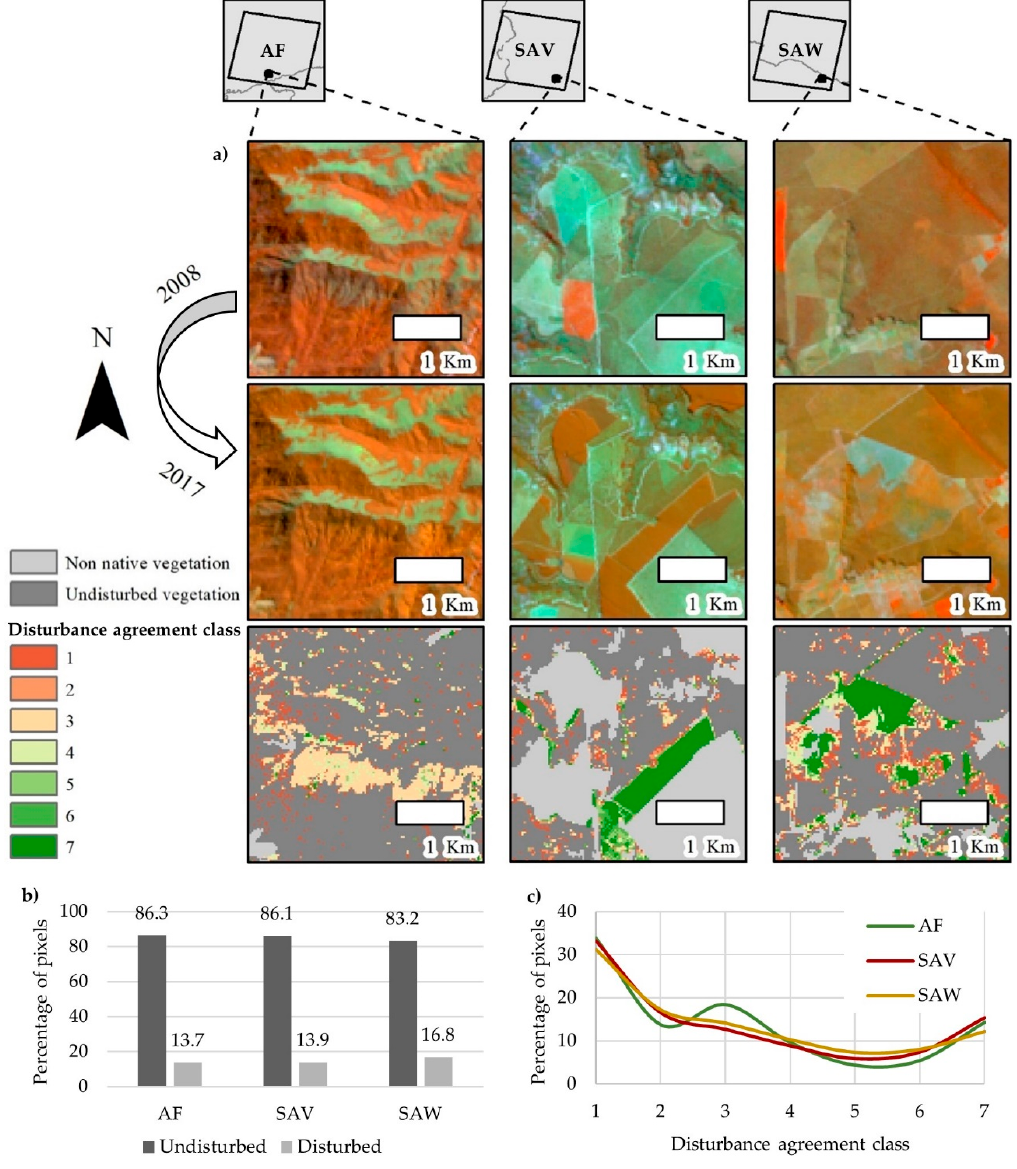
Figure 3. Overall agreement results. ( a ) Map insets for Atlantic forest (AF), savanna (SAV), and semi-arid woodland (SAW); ( b ) percentage of disturbed pixels by vegetation domain; ( c ) percentage of disturbed pixels by agreement class.